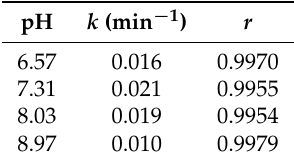
Table 6. Dynamics fitting of nano-Al 2 O 3 sedimentation in ASW with different pH